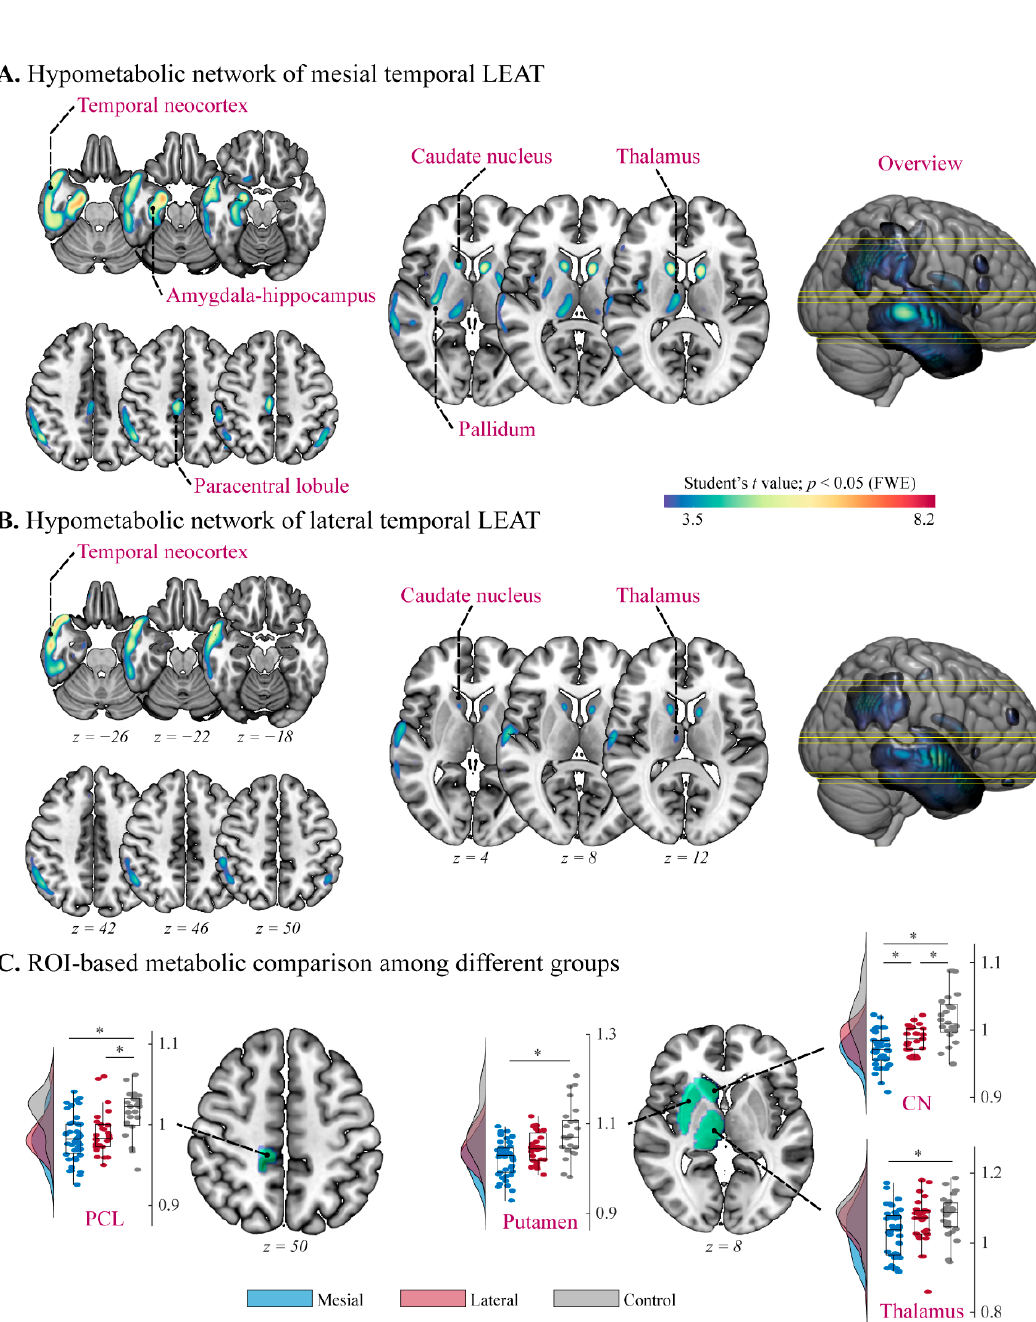
Figure 2. Group-level alterations in metabolism in patients with temporal lobe long-term epilepsy- associated tumors (LEAT). ( A , B ) Voxel-based t statistical parametrical map demonstrated the hypometabolic networks of mesial and lateral temporal LEATs, respectively. FWE: family-wise error. ( C ) Within-group comparison of the region of interest (ROI)-based metabolic value derived from significant group comparison. *: p < 0.05 (Bonferroni correction); PCL: paracentral lobule; CN: caudate nucleus; PET values among groups are expressed in boxplot as mean and standard deviation (SD).